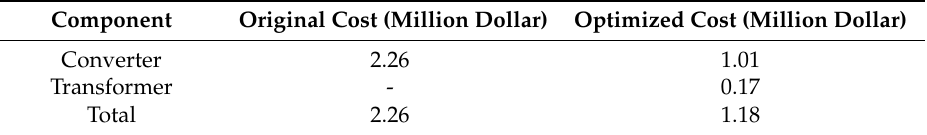
Table 2. Cost comparison of the MMC-DDI under conventional configuration and optimized